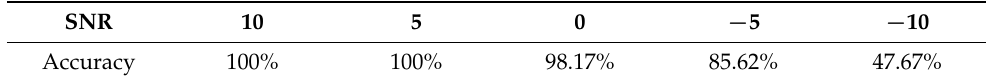
Table 2. Direction finding accuracy under different